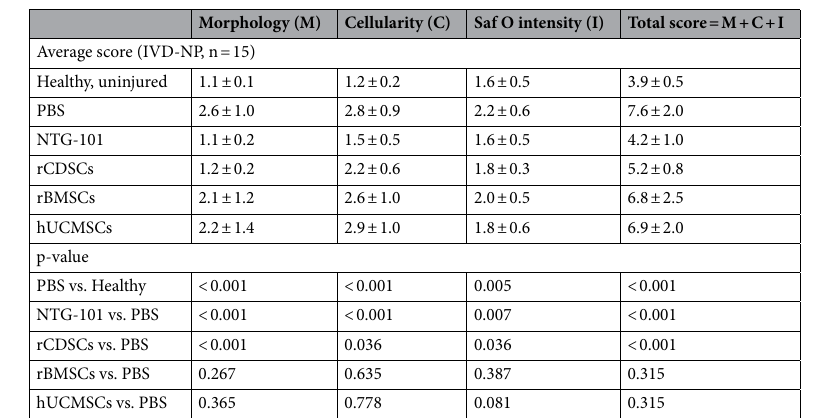
Table 1. Histological analysis of rat tail